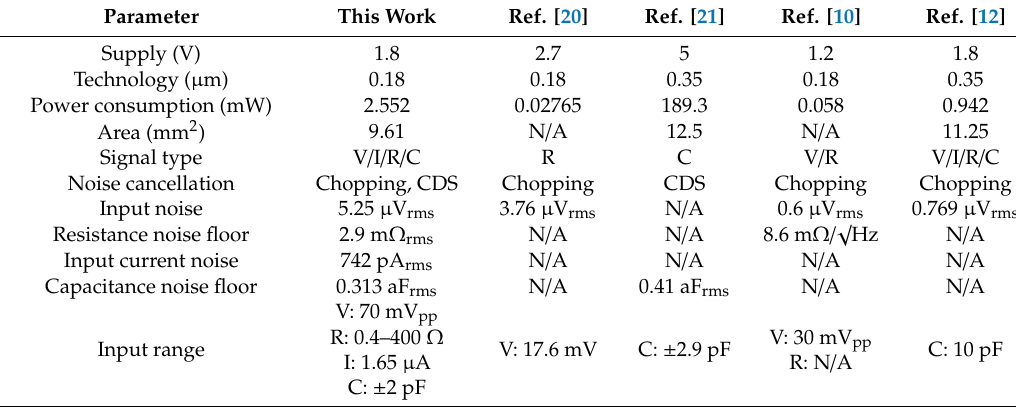
Table 3. Performance summary and